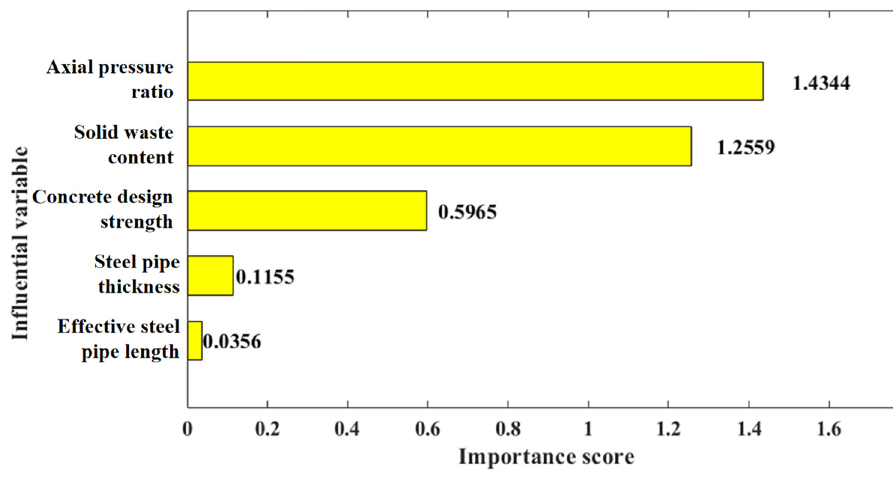
Figure 21: Variable importance analysis of FA – RF model for displacement ductility coe ffi cient